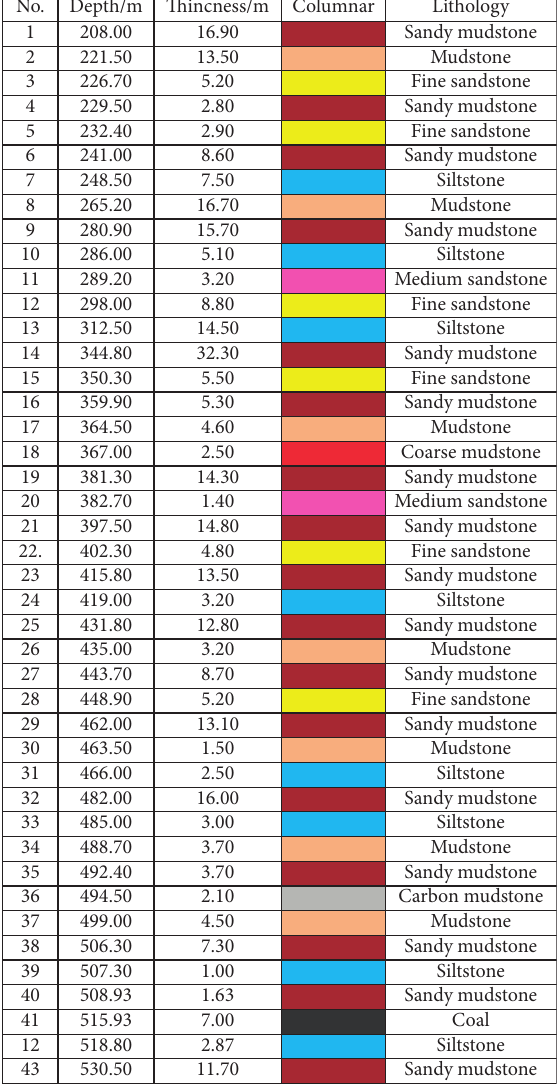
Figure 5: Roof stratum for the 4203 panel (not to